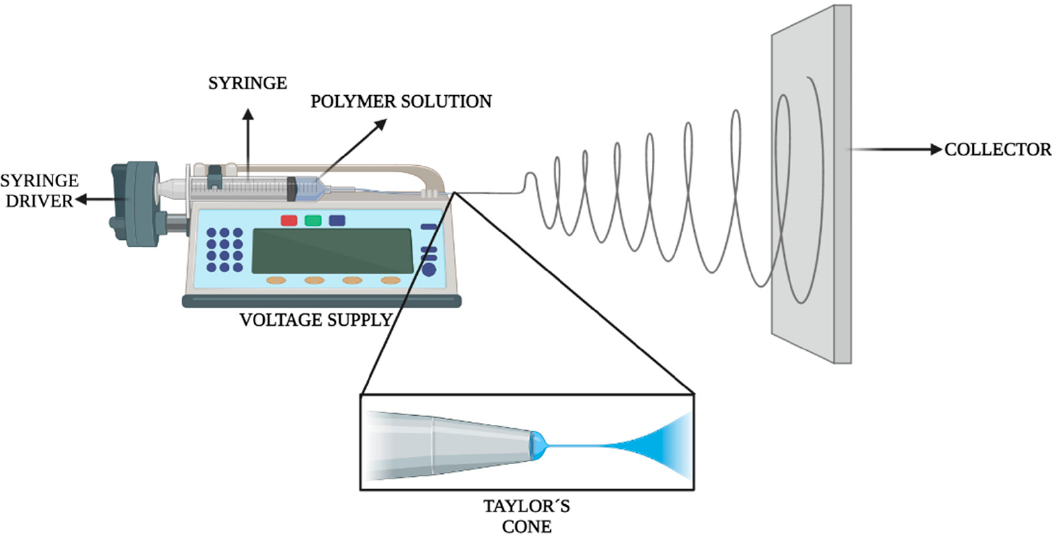
Figure 4. Illustration of the electrospinning method.